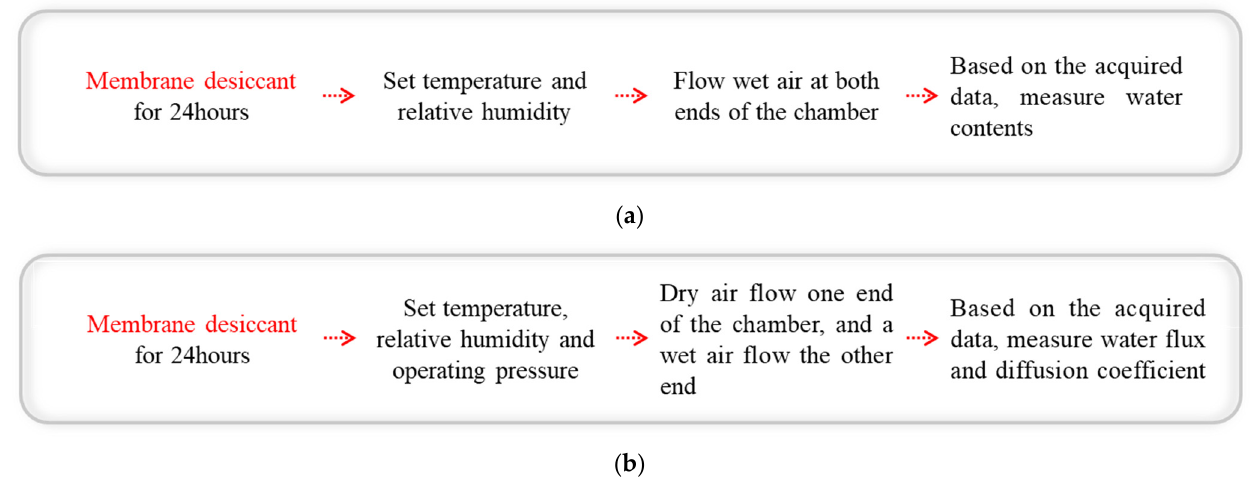
Figure 3. Experimental procedure. Measurement of ( a ) water content and ( b ) water-transport. Table 3. Experimental conditions for water-transport through the membrane.